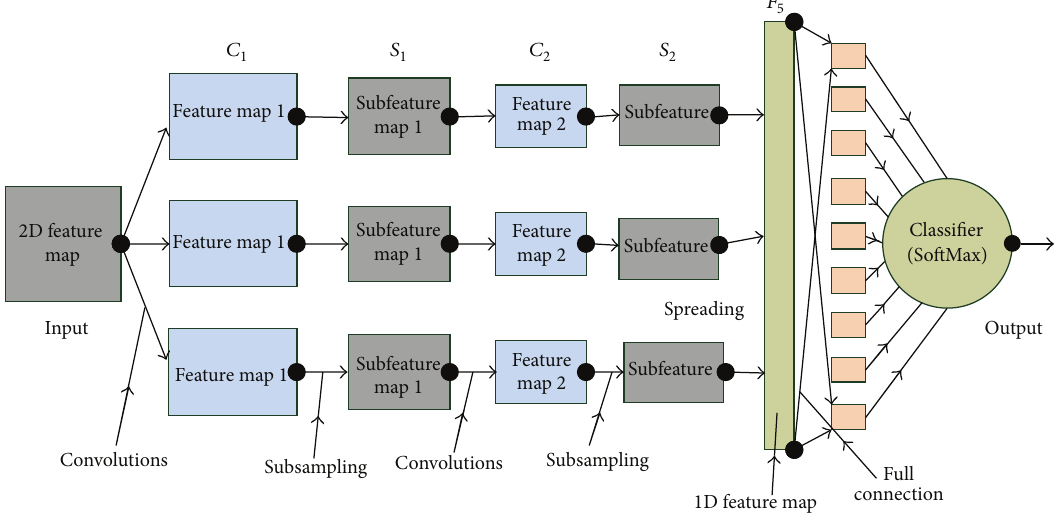
Figure 1: Architecture of convolutional neural